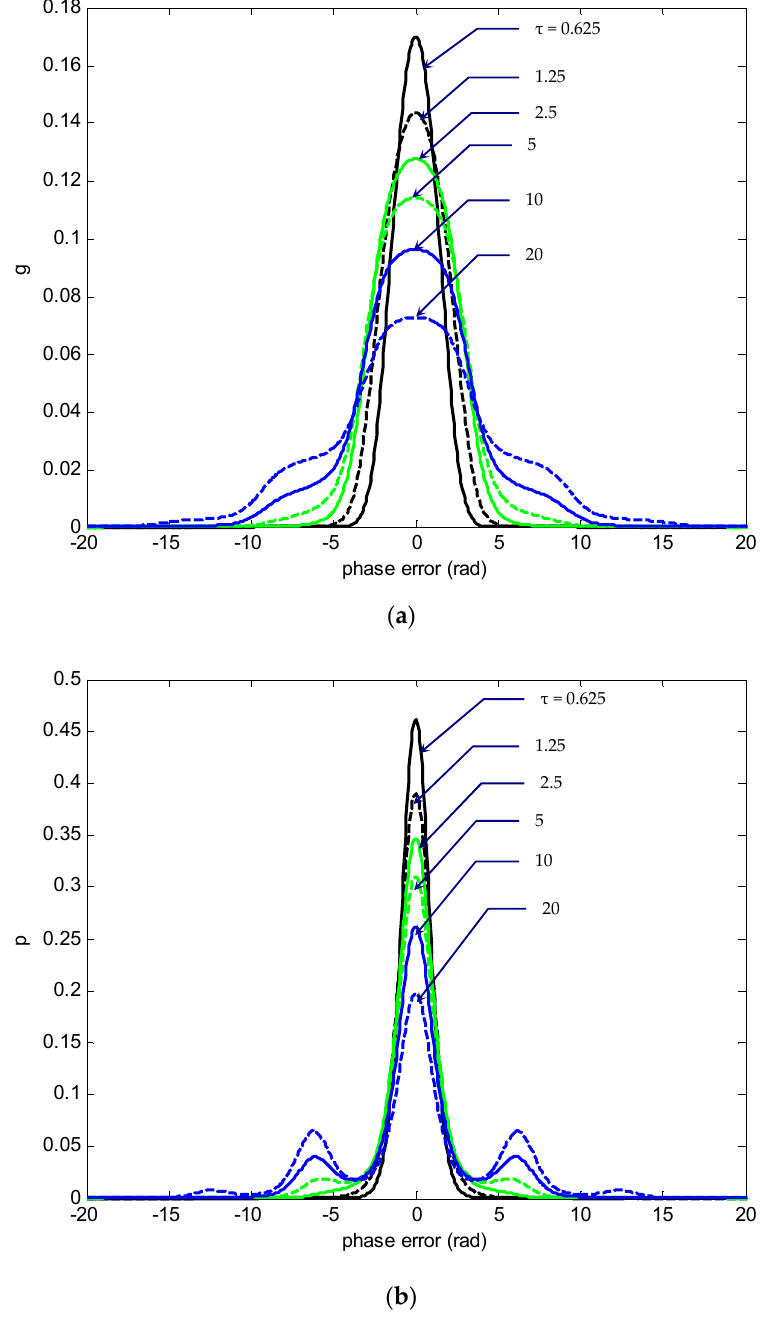
Figure 2. The time-evolution of the nonmodulo-2 π ( a ) density function g ( φ , τ ) and ( b ) PDF p ( φ , τ ) , of the phase error for the signal-to-noise ratio (SNR) α = 1 ( γ = 0 ).